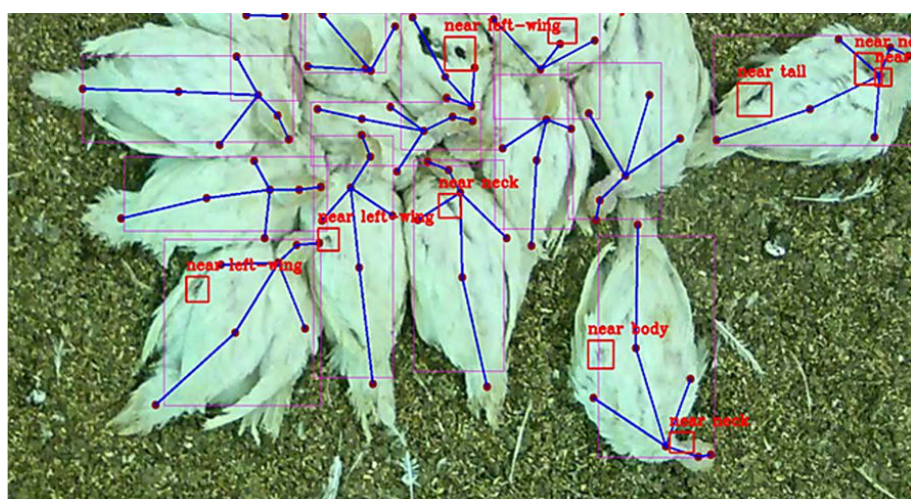
Figure 6. Combination of KPD generated in this study and injury detection from previous work [16] on the evaluation dataset. The keypoints are shown in lilac connected by blue lines. The supposed injuries detected are highlighted using red boxes and the classification of the injuries is marked using labels such as “near neck” or “near tail.”.